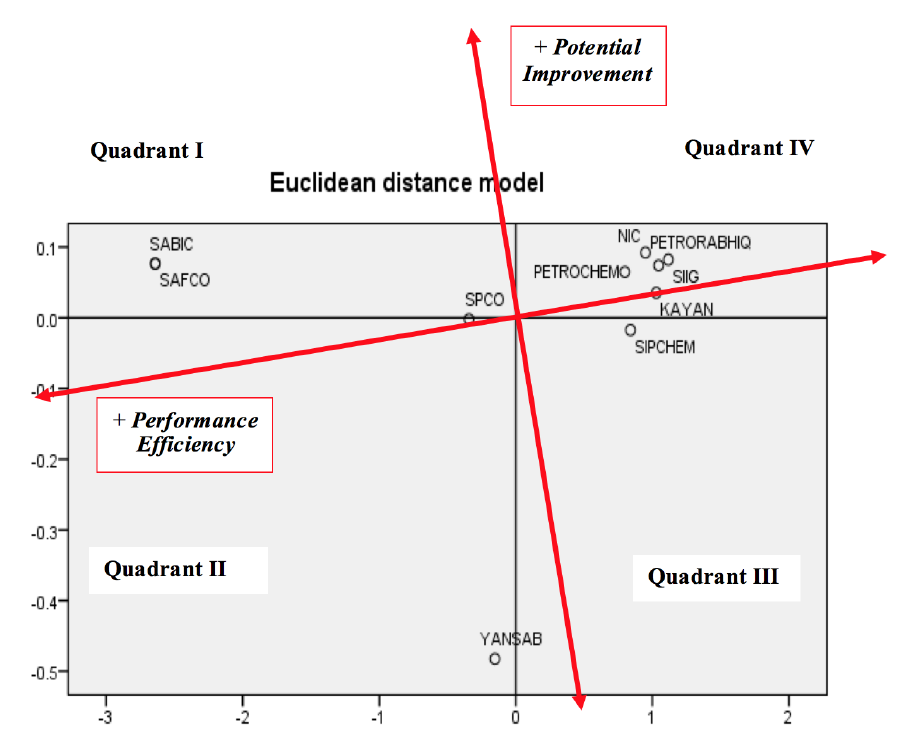
Figure 2. Multidimensional scaling (MDS) scatter plot of petrochemical companies in Saudi